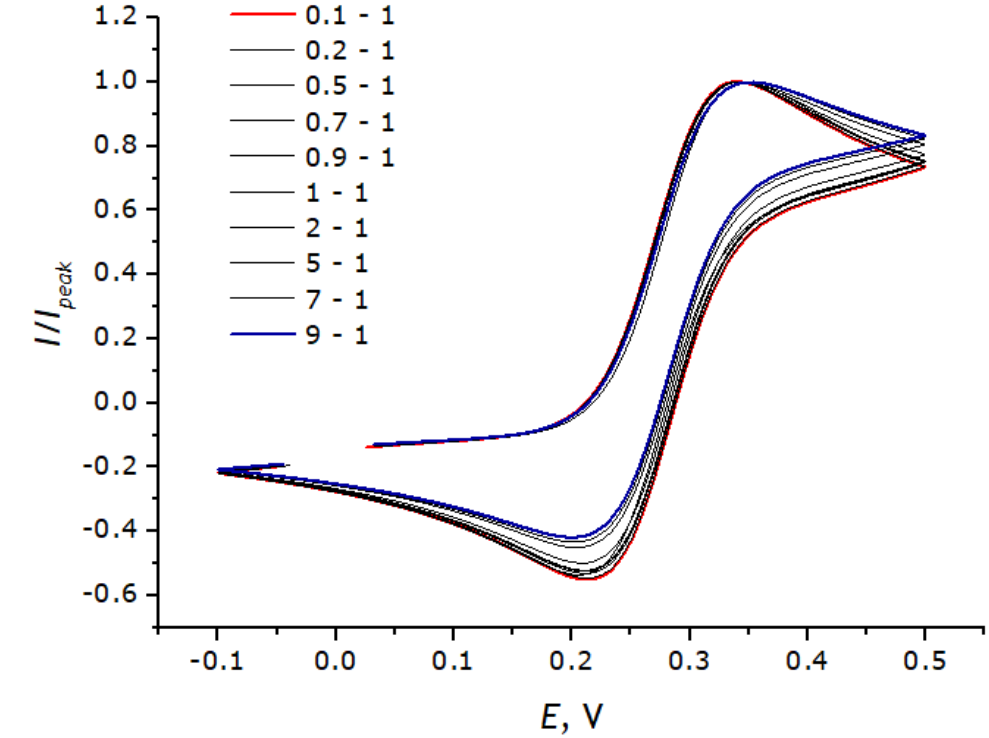
Figure 19. Cyclic voltammetry of mixtures with different ratios of substances with diffusion coef- ficients differing by a factor of 10. Ultramicroelectrode ensemble 20 µm, sweep rate 10 mV/s. Dependences of the peak position on the cyclic voltammetry program on the ratio of concentrations of substances with different diffusion coefficients at different sweep speeds were plotted using the model data (Figure 20).